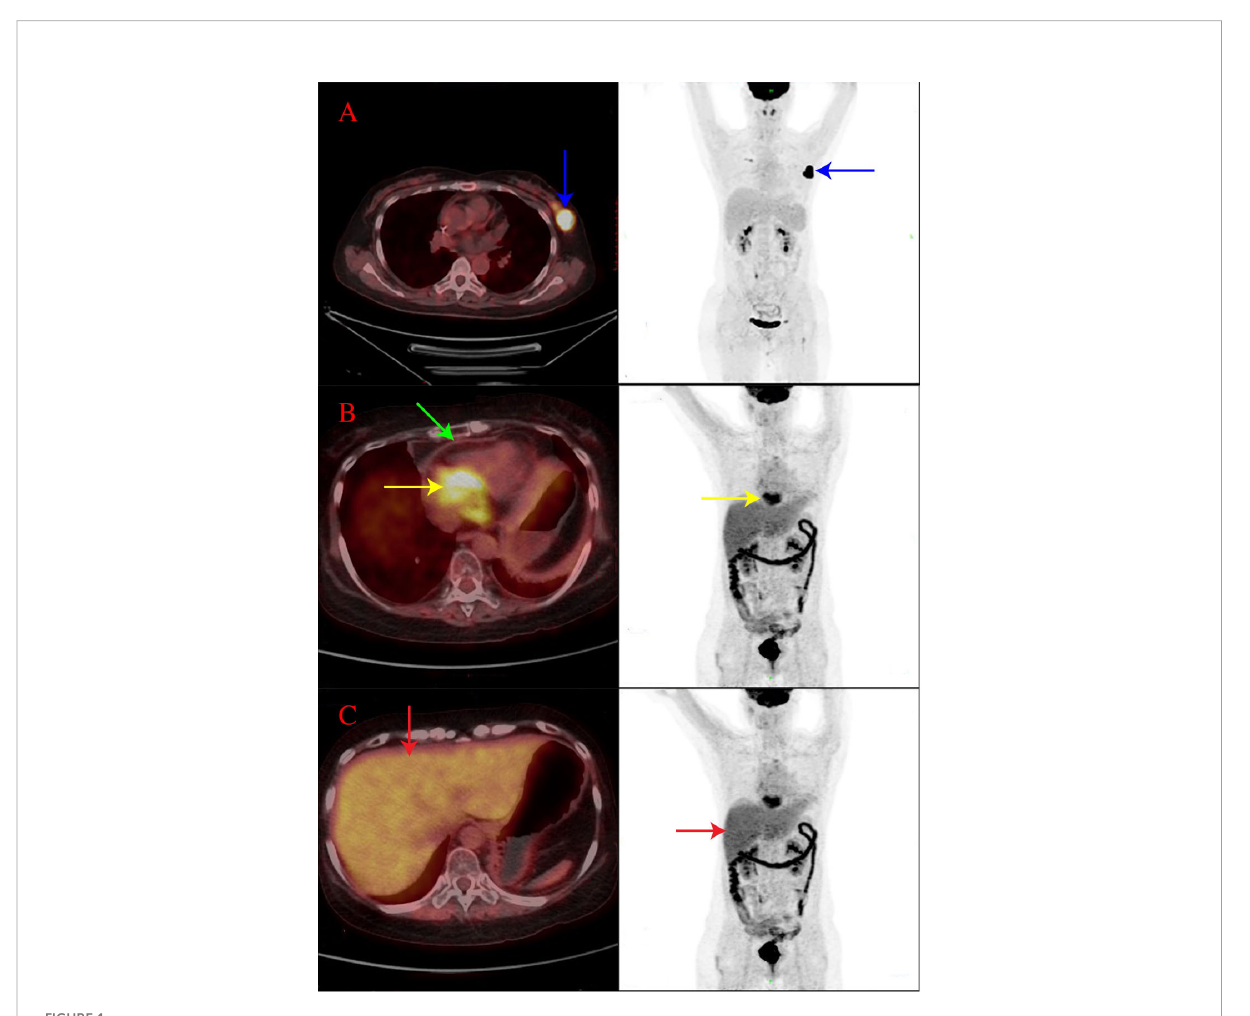
FIGURE 1 PET-CT fi ndings of the patient. (A) In September 2020, there was an irregular soft tissue mass in the upper outer quadrant of the breast (4.1 × 2.0 cm), with an SUV max of 23.0, as shown by the blue arrow. (B) In November 2021, there were a cardiac mass (6.0 × 4.4 cm), with an SUV max of 10.5, as shown by the yellow arrow and a diffusely thickened pericardium, with an SUV max of 2.0, as shown by the green arrow. (C) In November 2021, there was an abnormal uptake in the liver, with an SUV max of 5.0 and a Deauville score of 5 points, as shown by the red